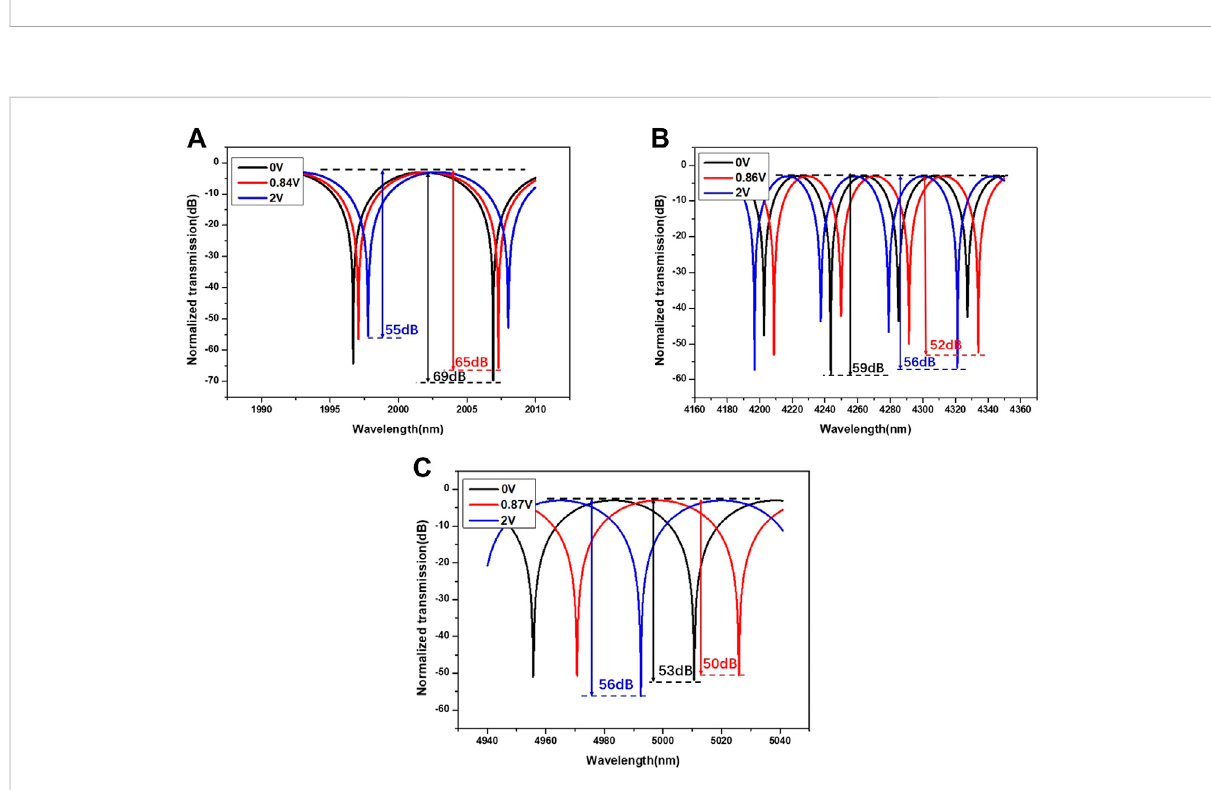
4.3 μ m wavelength; the modulation voltages of SiGe/Si PIN 0.87 V and 1.83 V at 5 μ m wavelength, then the modulated voltage of SiGe/Si PIN heterojunction modulator is lower 52.5% than that of Si modulator under the same modulated effect at 5 μ m wavelength. As the input optical